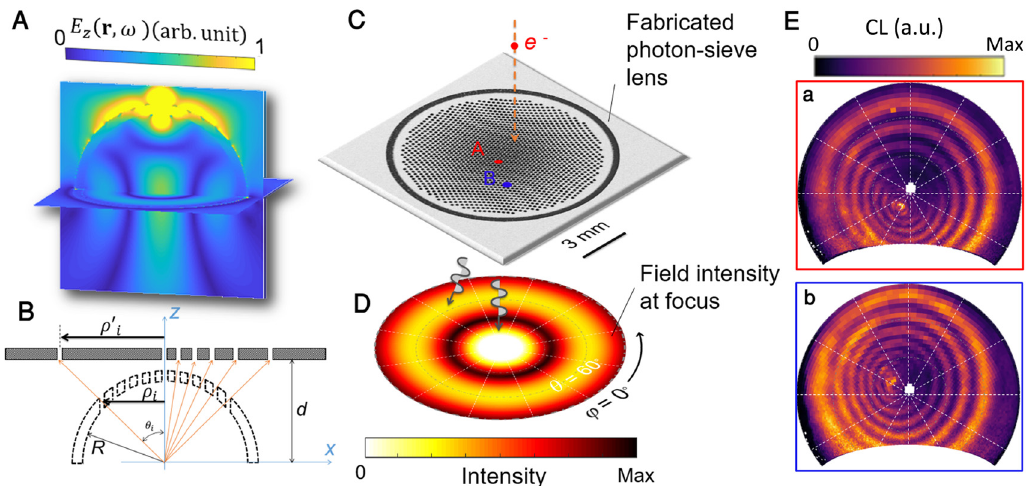
Figure10: (A)Focusedlightfromahemisphericalgoldthinfilmcomprisingahexagonallatticeofnanoholesinteractingwithanelectronbeam at the kinetic energy of 200 eV. (B) The pinholes are projected from spherical to Cartesian coordinate system to construct planar electron- driven photon sources with focused radiation. (C) Scanning electron microscope image of the fabricated photon sieve. (D) Calculated electric fi eld intensity at the focal point situated at the distance of 5.6 mm from the structure. (E) Angle-resolved cathodoluminescence maps at different electron impact positions marked by A and B in the panel at 10 C, at the energy of E = 1.6 eV